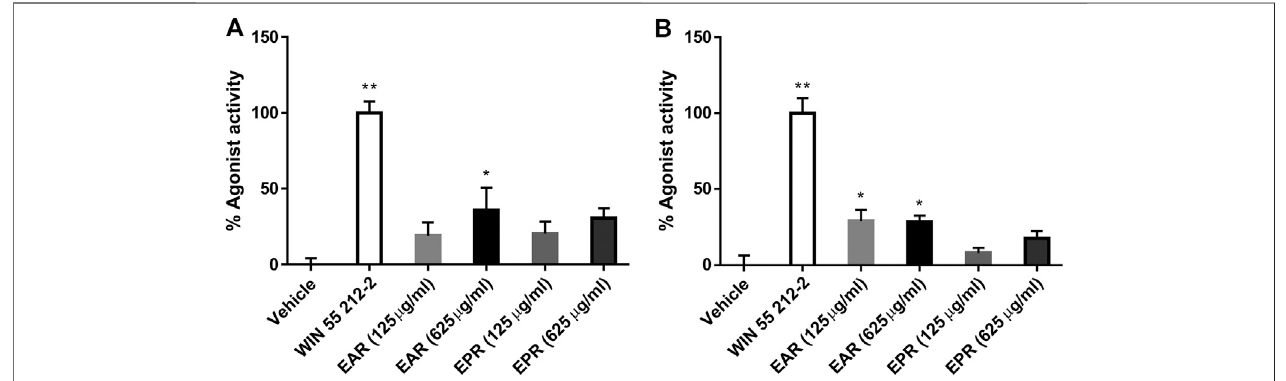
FIGURE 2 | Mean agonist effects of E. angustifolia (EAR, n (cid:1) 11) and E. purpurea (EPR, n (cid:1) 9) root extracts on CB1 (A) and CB2 (B) receptor in CB receptor redistribution assays, expressed relative to the positive control WIN 55,212-2 (1 µm). An analysis of variance (ANOVA) was performed to evaluate the variance between samples followed by Dunnett ’ s test post hoc relative to the vehicle (0.5% ethanol) control. * p < 0.05; ** p <